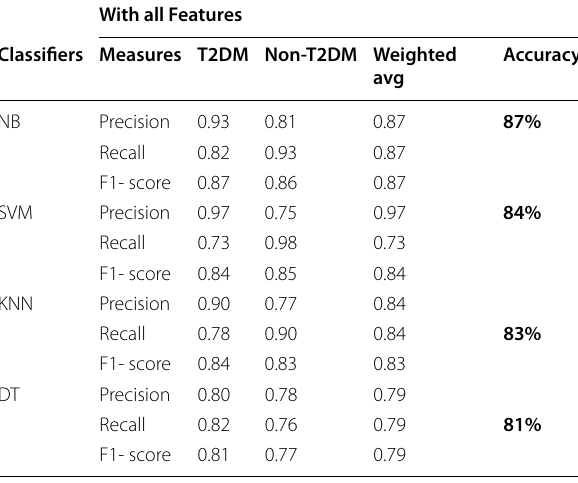
Table 2 Performance of the classifiers for cases and control With all Features